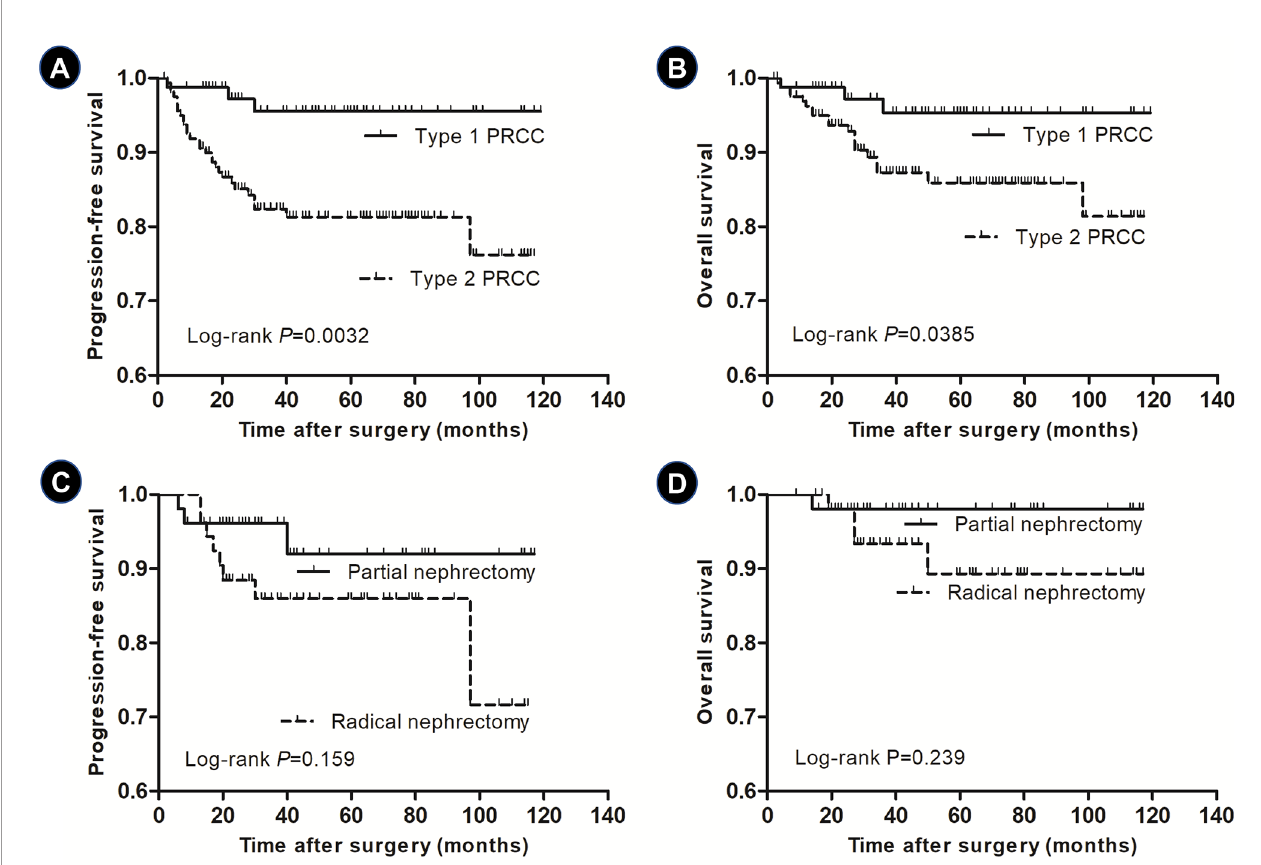
FIGURE 1 | (A) Comparison of progression-free survival (PFS) between type 1 and type 2 papillary renal cell carcinoma (PRCC) ( p = 0.0032). (B) Comparison of overall survival (OS) between type 1 and type 2 PRCC ( p = 0.0385). (C) Comparison of PFS of type 2 PRCC patients with pT1 stage receiving partial nephrectomy and radical nephrectomy ( p = 0.159). (D) Comparison of OS of type 2 PRCC patients with pT1 stage receiving partial nephrectomy and radical nephrectomy ( p = 0.239).